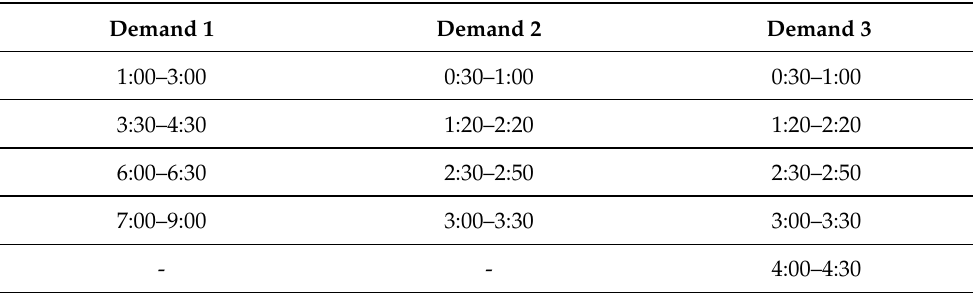
Table 2. Start and end times of the rush hours for each demand. Demand 1 lasted 10 h, Demand 2 lasted 4 h, and Demand 3 lasted 5